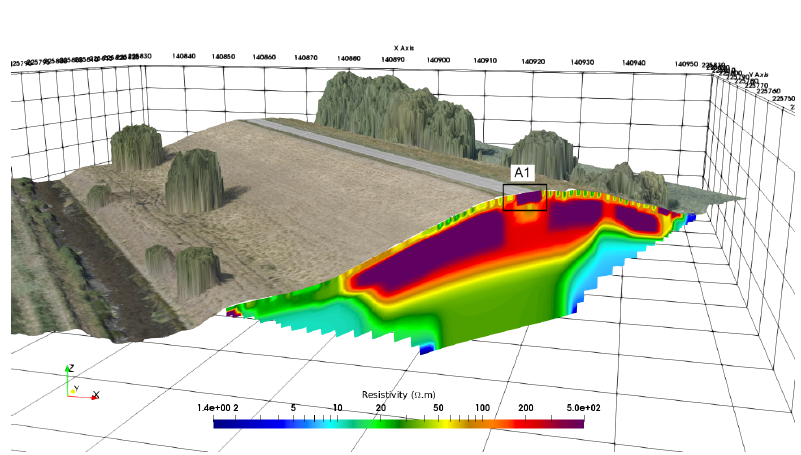
Figure 6. Combined DTM and ERT profile along the T10 profile (see figure 3).